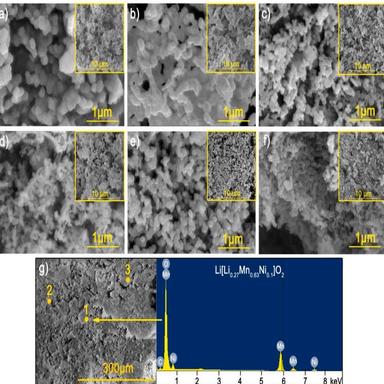
SEM images of a) LiO2, b) LiO2, c) LiO2, d) LiO2, e) LiO2 and f) Li O2; g) Scanning electron microscope micrographs along with EDS analysis of the LiO2 powders.